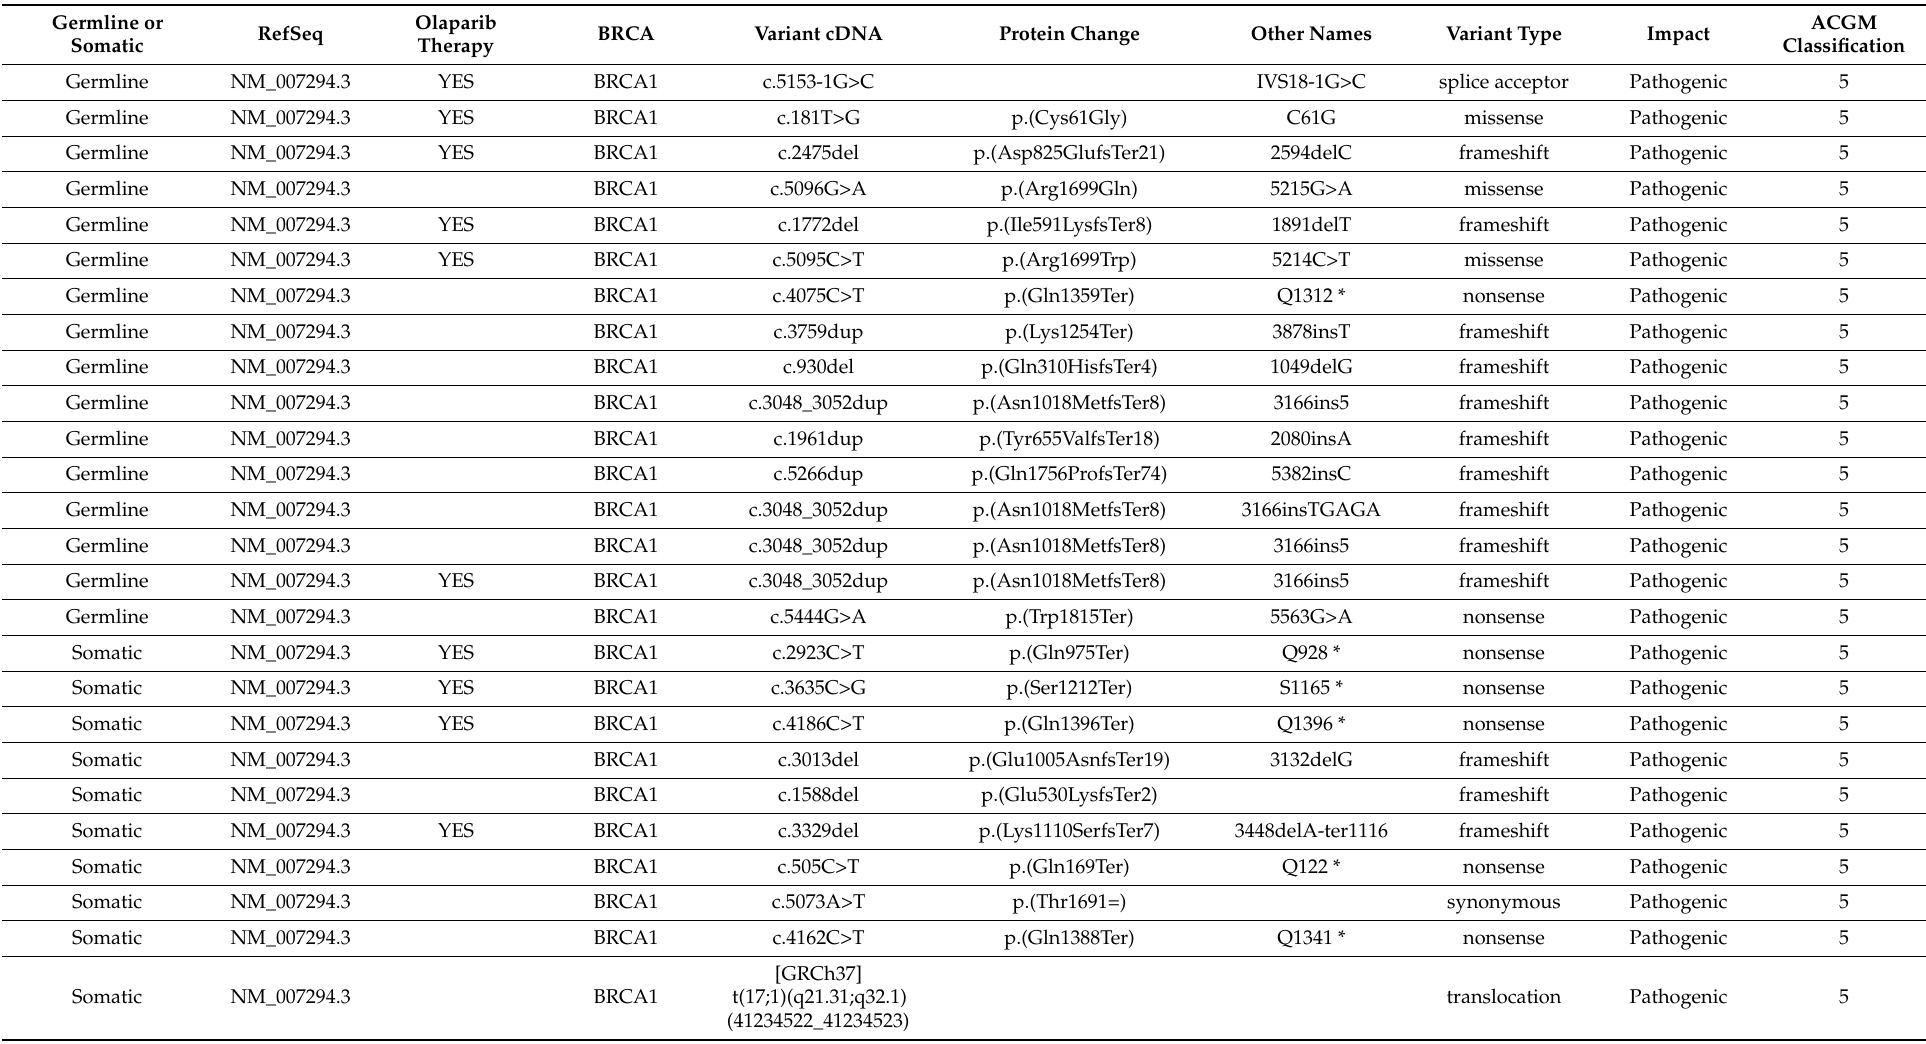
Table 2. Pathogenic BRCA1 and BRCA2 variants detected in this